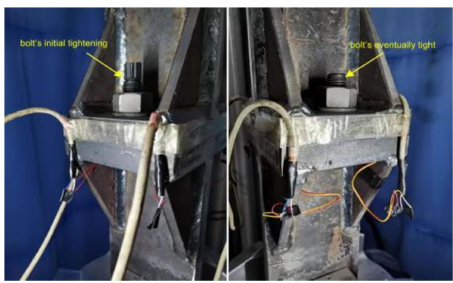
Figure 5. Comparison of M24 torsional shear-type bolt before and after pretightening